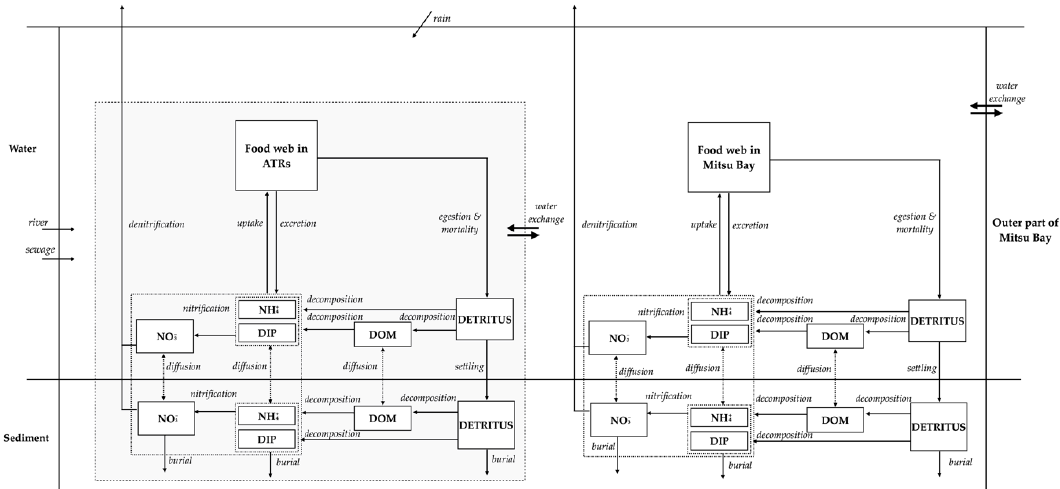
Figure 2. Model framework illustrating nutrient cycling in Mitsu Bay including the artificial timber reef (ATR) areas and other external processes. DOM: dissolved organic matter, DIP: dissolved inorganic phosphorus, NH + : ammonium, NO − : nitrate.